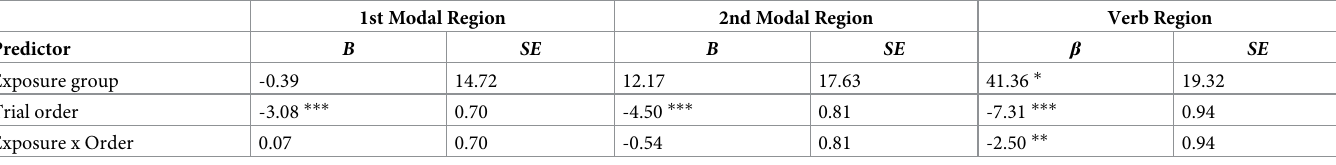
Table 8. Experiment 4 self-paced reading fixed effects summary for the three regions of analysis: The 1st modal region, the critical 2nd modal region, and the spill- over region. 1st Modal